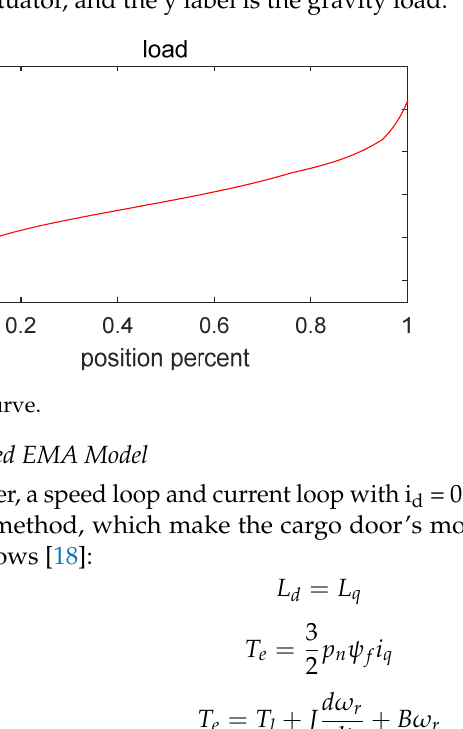
Figure 2. Function diagram of the cargo door actuation system.